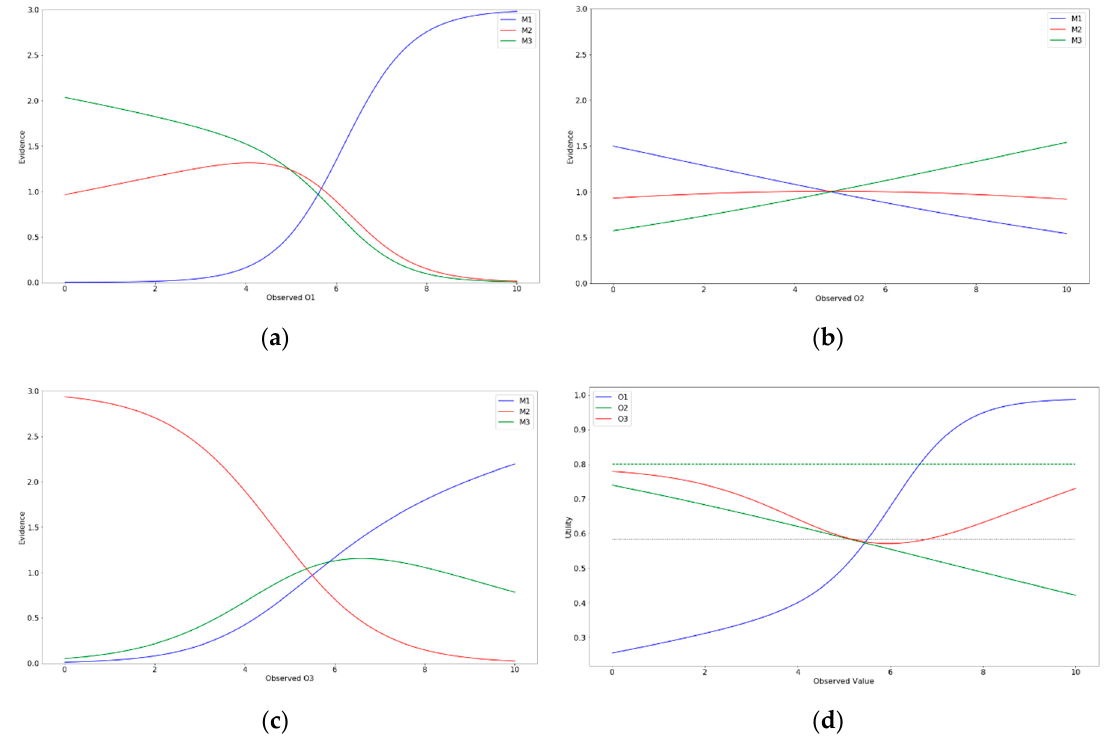
Figure 5. Evidence for each model ( M1 , M2 , and M3 ) based on observed value of: ( a ) O1; ( b ) O2; ( c ) O3; ( d ) probability-weighted forecast utility as a function of observed value for each individual observation. Dashed lines: average utility before data collection (black) and minimum acceptable utility (green).